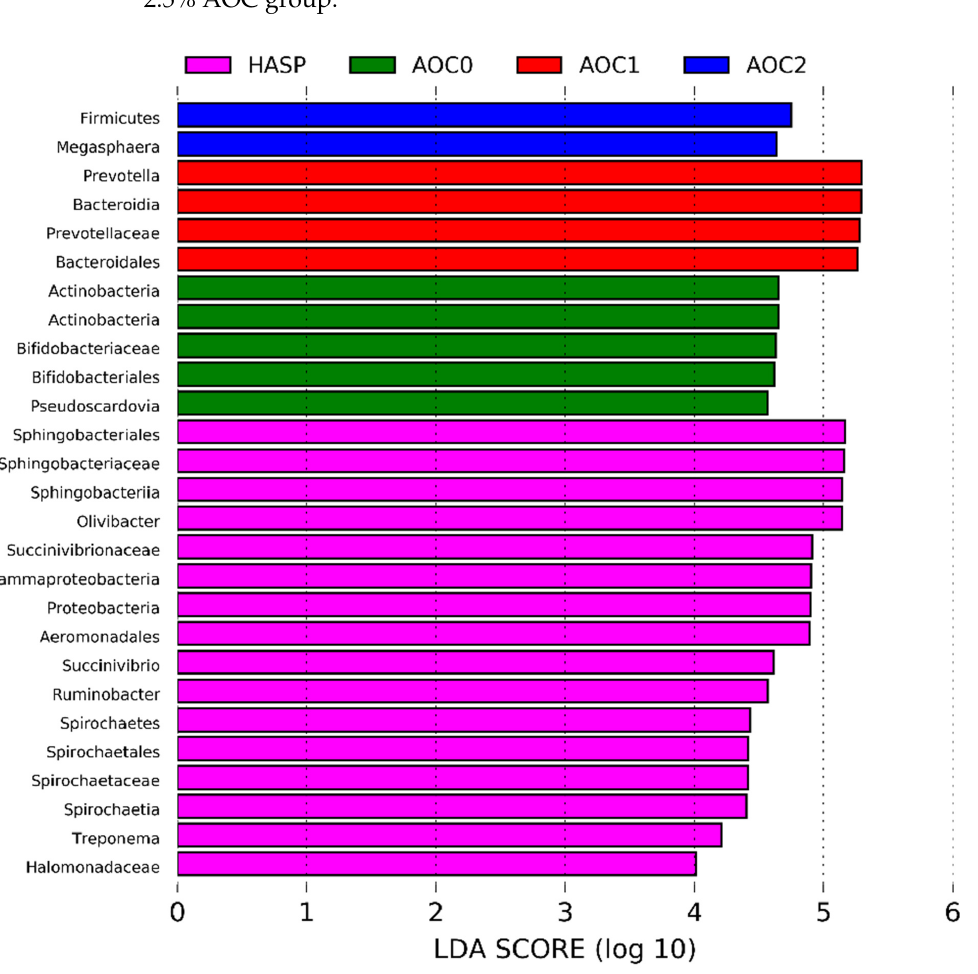
Figure 2. The difference of bacteria taxa in the addition of AOC under a severe SARA with Linear discriminant analysis (LDA) effect size (LEfSe) analysis.